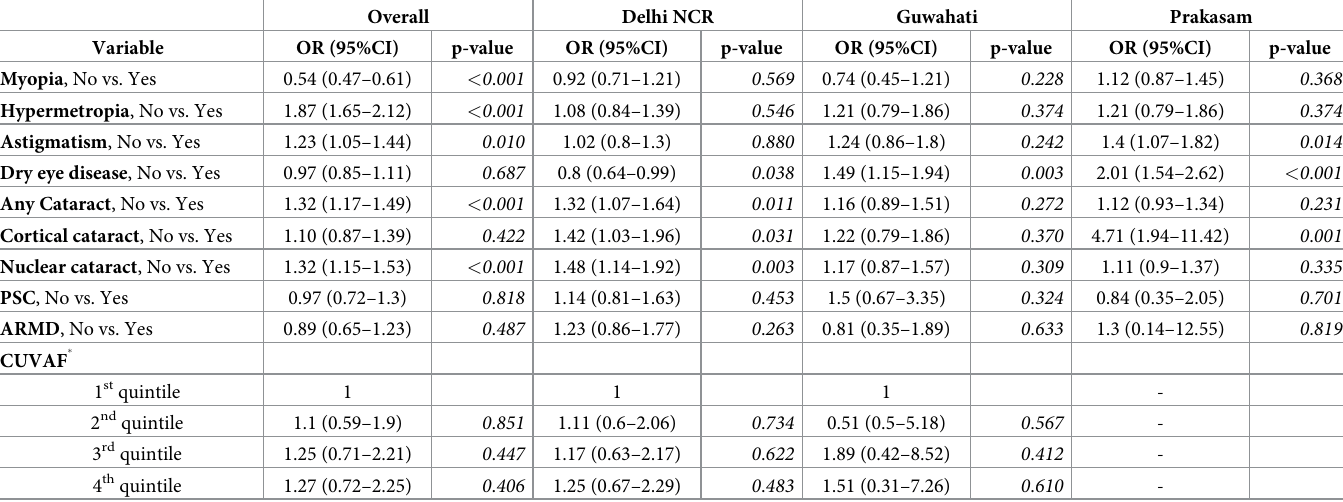
Table 3. Association of pterygium with CUVAF and ophthalmological